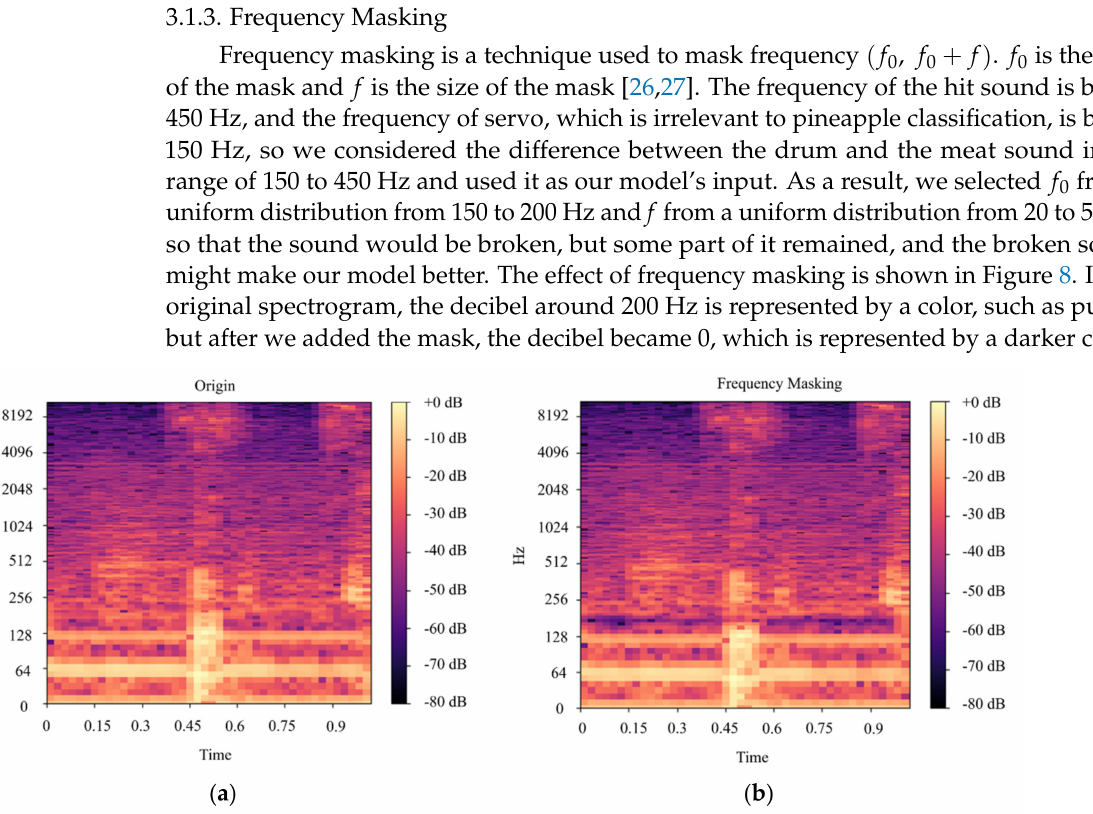
Figure 8. Spectrogram before and after frequency masking operation, ( a ) Original spectrogram, ( b ) spectrogram after frequency masking.